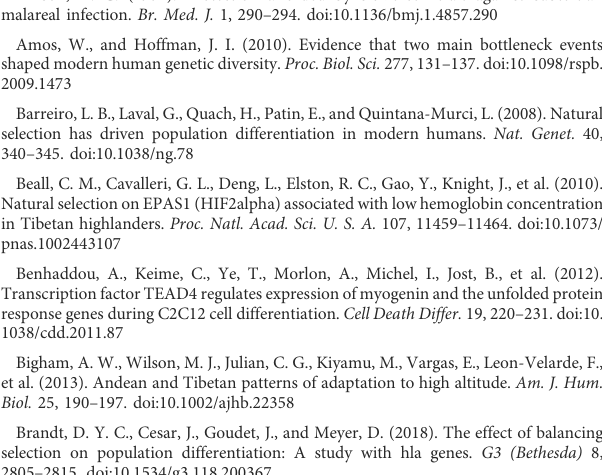
SUPPLEMENTARY FIGURE S1 Correlation of 450 k methylation with pyrosequencing. Correlation of beta values generated using the Illumina 450 k methylation microarray (x-axis) and percent methylation calculated from thepyrosequencing analysis. The gray band surrounding the blue regression line represents the 95% con fi dence interval. We see that those samples with the AA genotype demonstrated minimal methylation (i.e., Beta values close to 0%) when analyzed through methylation array as well as pyrosequencing. Those with the heterozygous genotype (GA) had roughly (beta values representing 50% percent methylation). Lastly those that were homozygous for the G allele had thehighestmethylationvalueswithBetavalues indicating approximately 70%